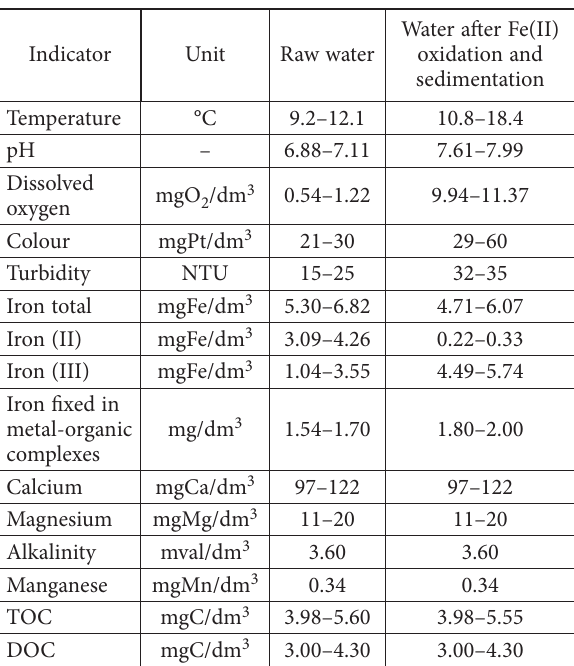
Table 1. Characteristics of groundwater quality before and after Fe(II) oxidation and sedimentation